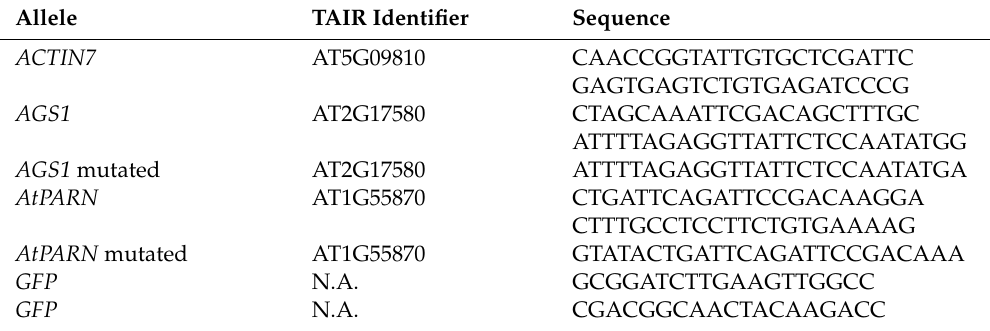
Table A1. Primers used to genotype transgenic plant lines.